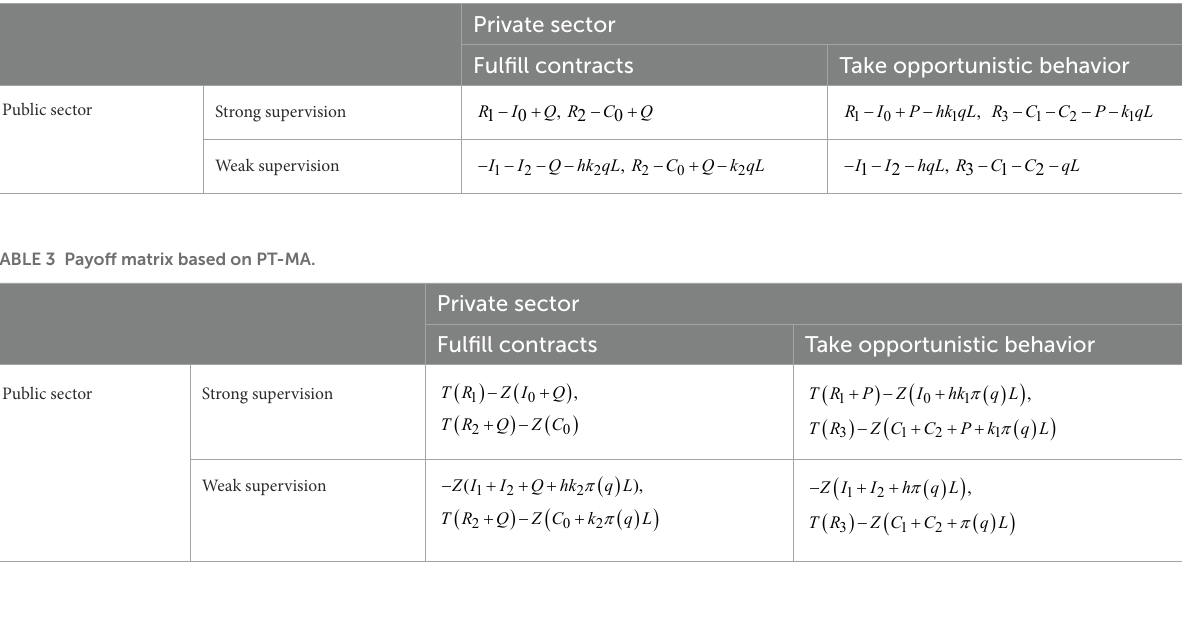
TABLE 2 Traditional payoff matrix based on the expected utility.